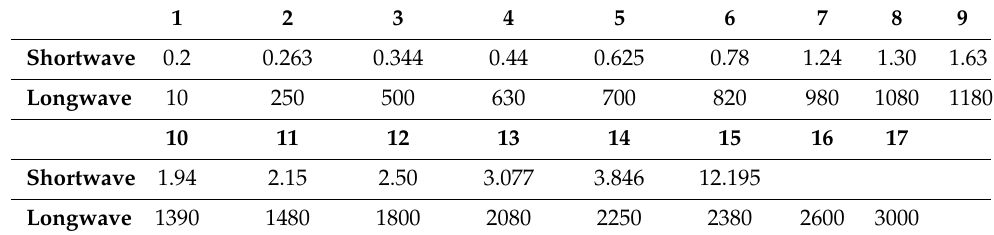
Table 1. The shortwave and longwave broadband spectral wavelength